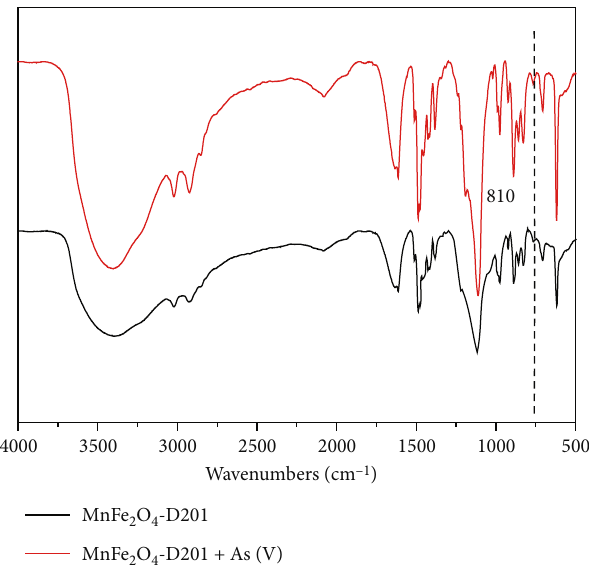
Figure 7: FTIR of MnFe